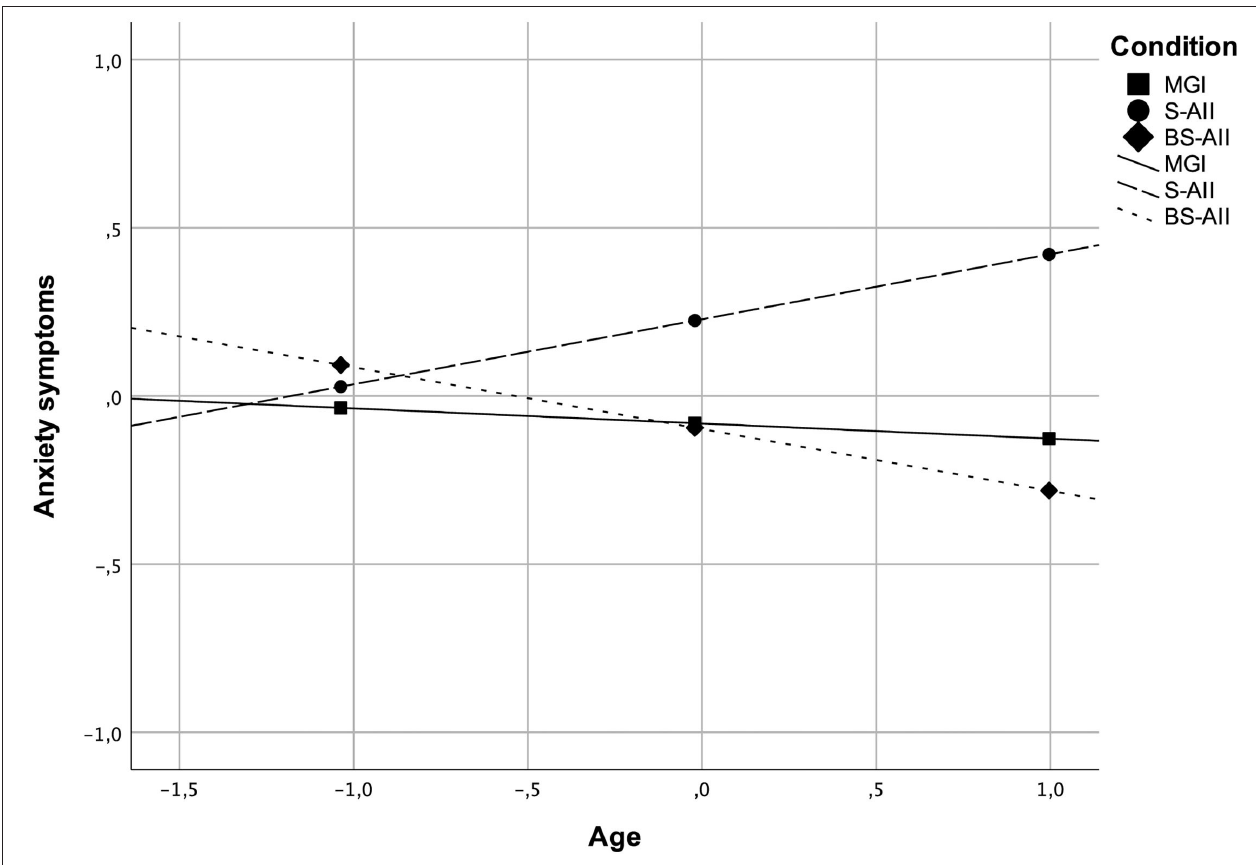
FIGURE 2 | Moderating effects of age between the group assignment and anxiety symptoms at post-intervention (T2). Both the x - and y -axis represent standardized values. salient, but only for those who have accessibility to